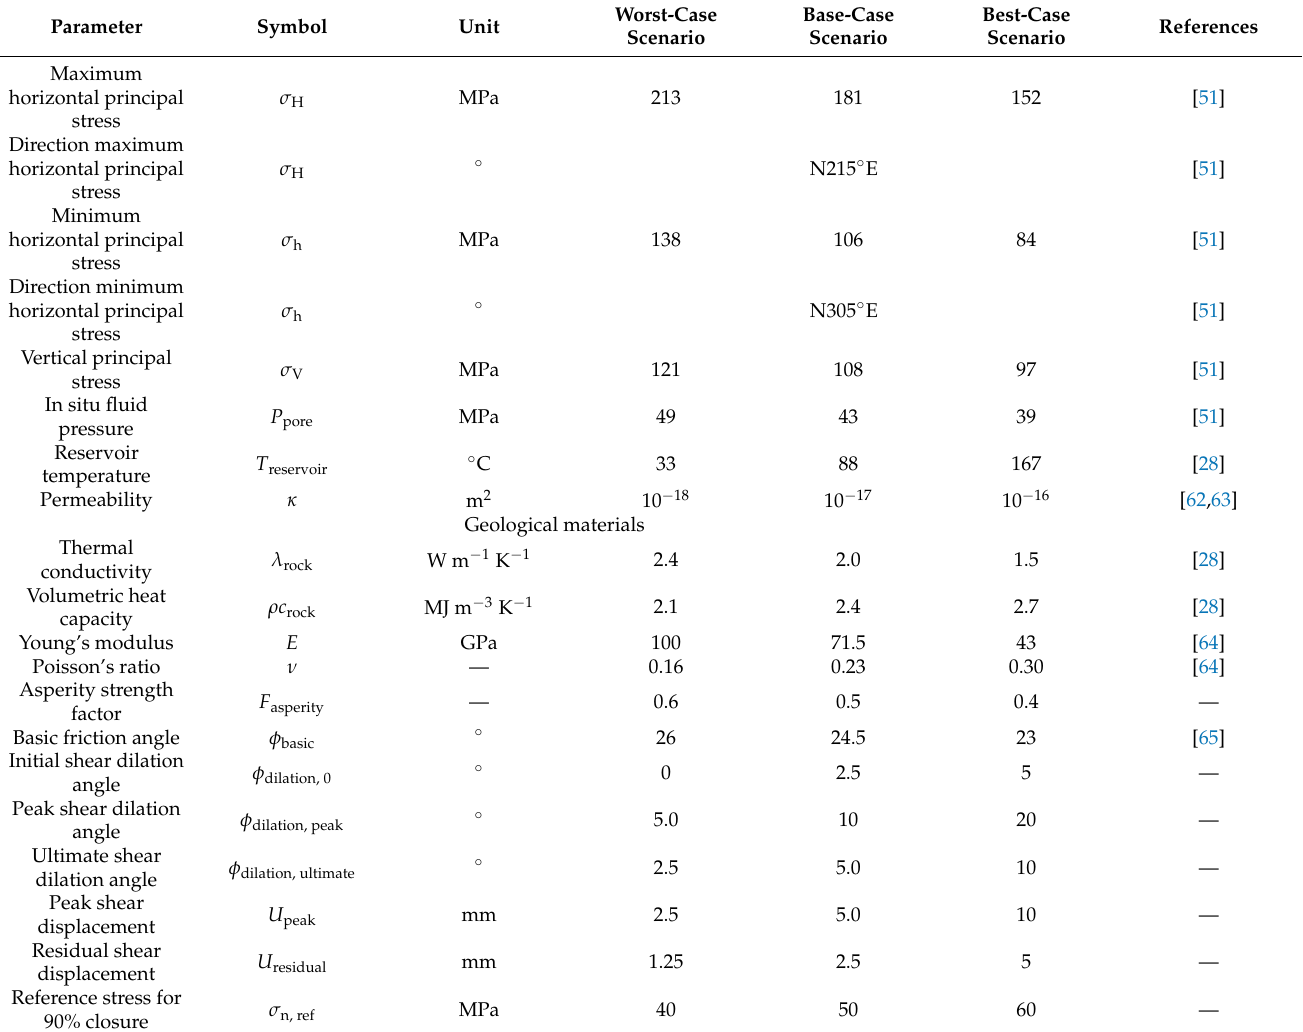
Table 1. Sensitivity analysis for the properties of the